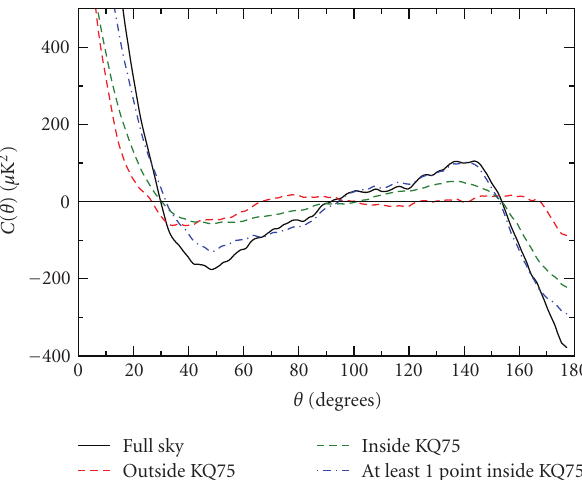
Figure 6: The two-point angular correlation function from the WMAP 5-year results. Plotted are C ( θ ) for the ILC calculated separately on the part of the sky outside the KQ75 cut (dashed line), inside the KQ75 cut (dotted line), and on the part of the sky with at least on point inside the KQ75 cut (dotted-dashed line). For better comparison to the full-sky C ( θ ) (solid line), the partial sky C ( θ ) has been scaled by the fraction of the sky over which they are calculated. Adopted from